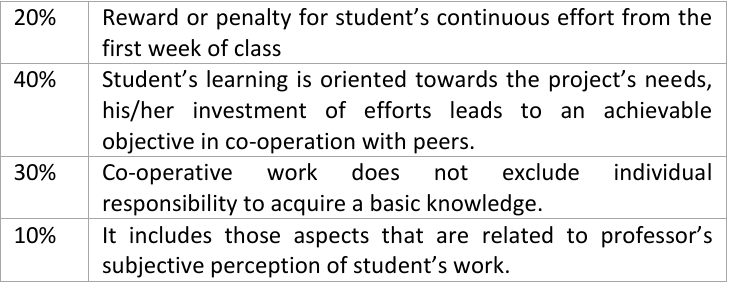
Table 2: Marking methodology